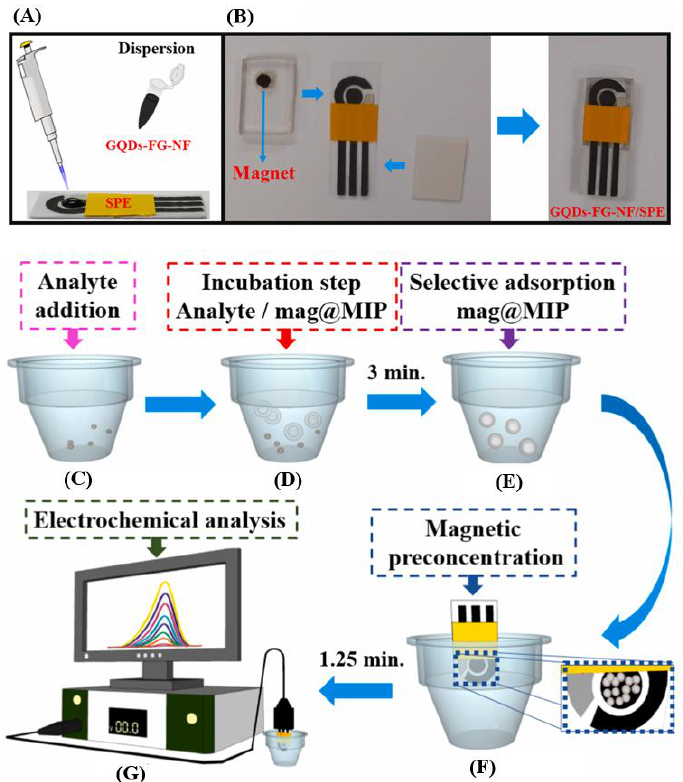
Figure 13. ( A ) SPE modification with GQDs-FG-NF and ( B ) fixing the magnet to the modified SPE. Sensor mechanism: ( C ) addition of the analyte; ( D ) incubation step with the mag@MIP in the analyte solution; ( E ) analyte adsorption by the mag@MIP; ( F ) separation of the analyte-mag@MIP with the electrode magnet (GQDs-FG-NF/SPE), and ( G ) steps of electrochemical analysis. Reprinted with permission from Elsevier from Ref. [156].